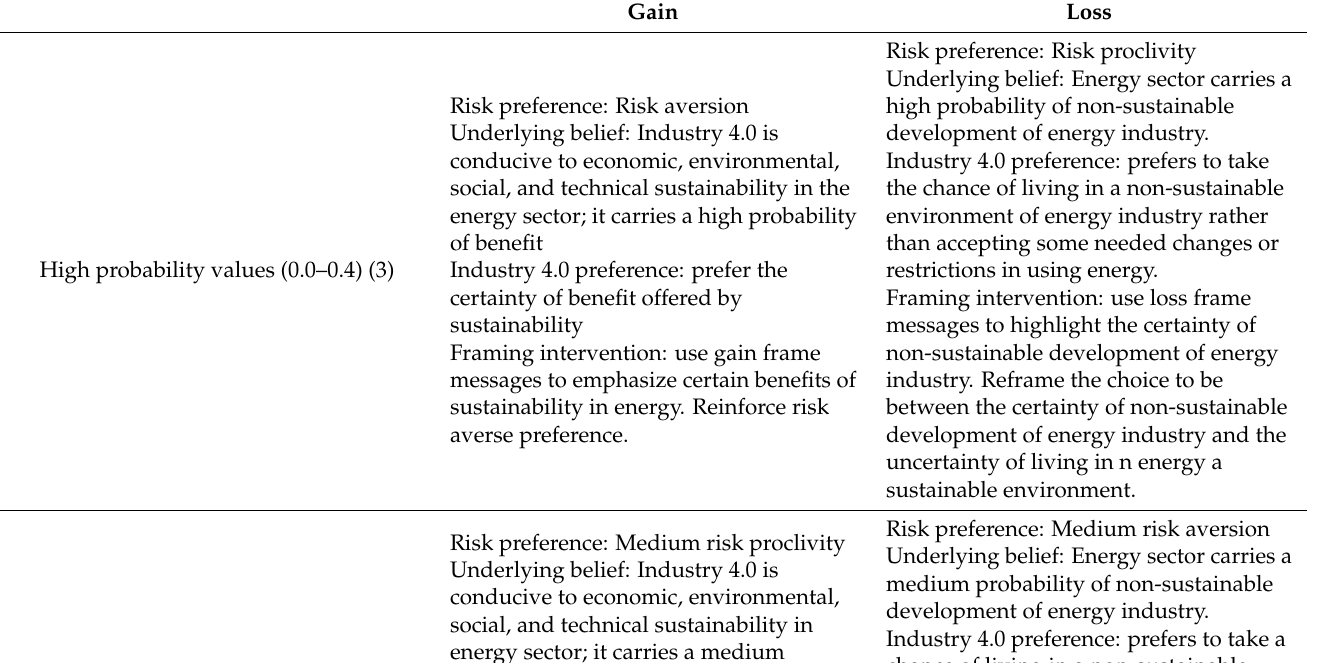
High probability values (0.0–0.4)